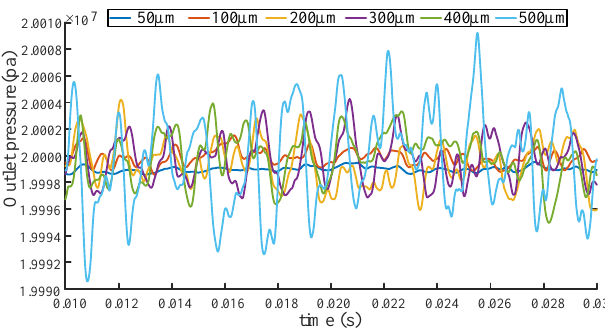
Figure 14. Pressure fluctuation curve under different end wear clearance.